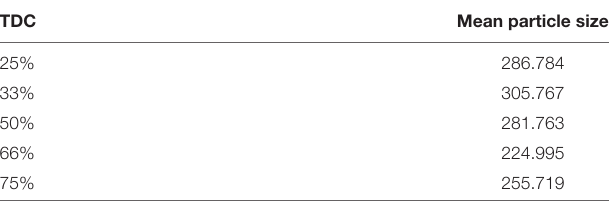
TABLE 3 | Mean particle size of the prepared products using different TDC.